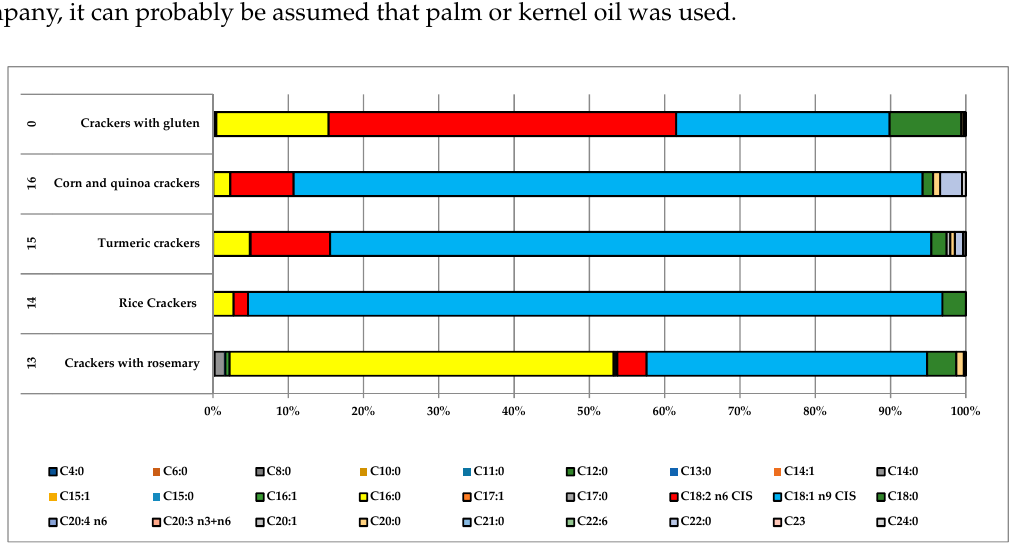
Figure 5. Comparison between the fatty acid distributions of the gluten-free crackers and gluten- containing crackers.